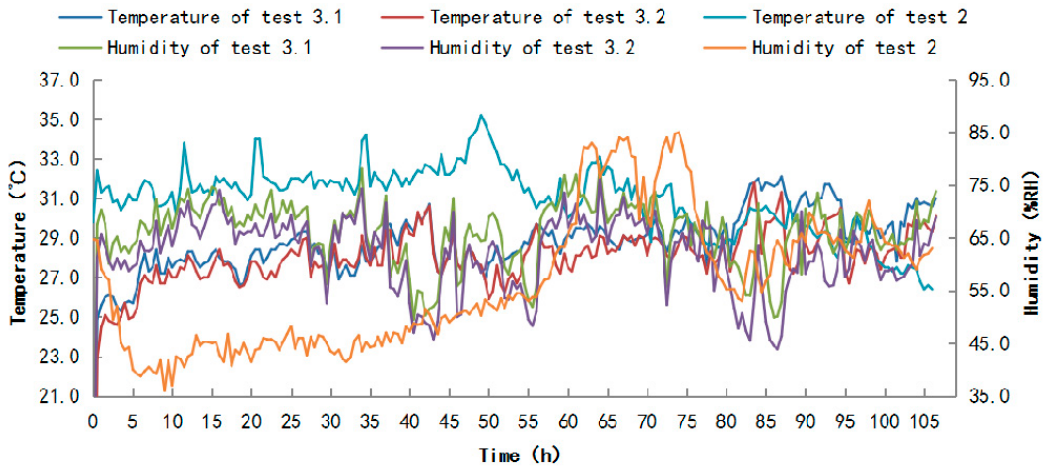
Figure 4. The temperature and humidity parameter curves of survival test (test 2 and test 3). Table 2. Environmental parameters of the experiments.